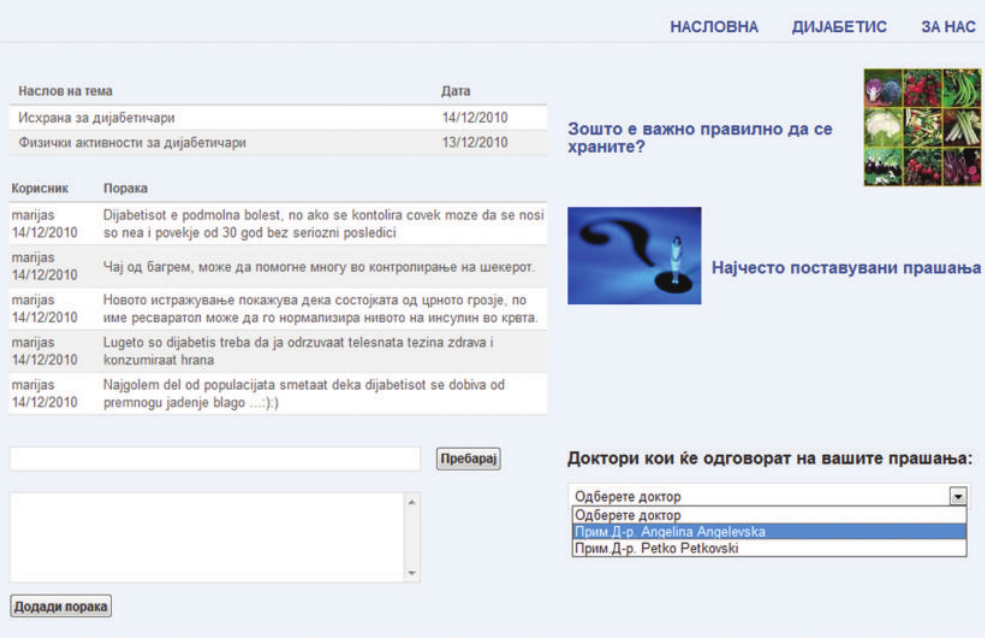
Figure 2: Social collaboration